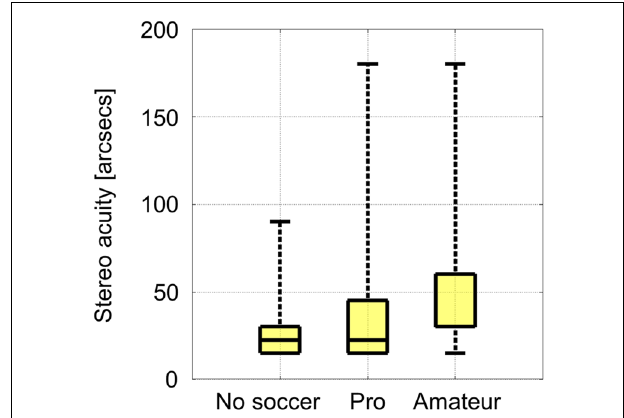
FIGURE 3 | Median of static stereo acuities per group. The median of the amateur group corresponds to the lower bound of the box, the 25th percentile of 30 arcsecs.